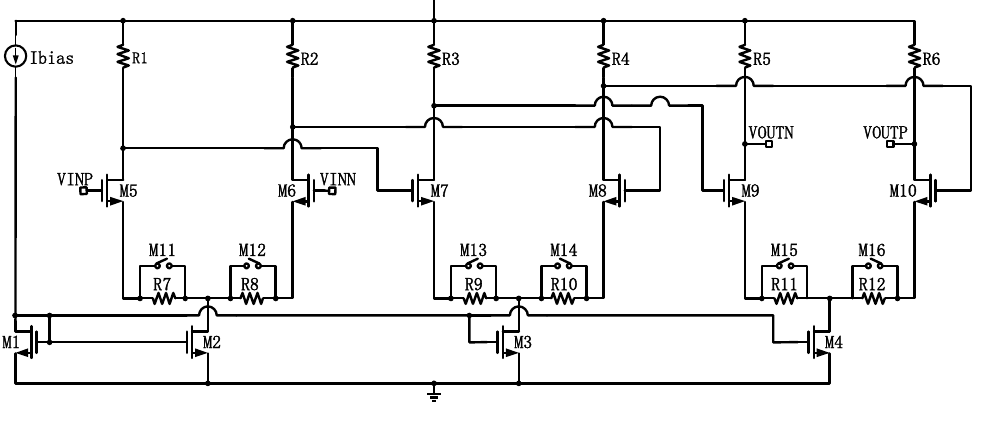
Figure 5. Pre-amplifier structure. Table 1. Comparison of three gain programmability schemes.